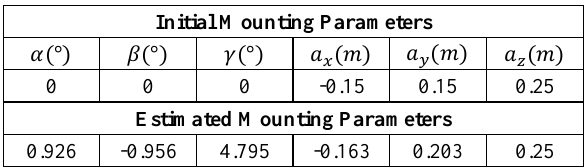
Table 3. Calibration result, mounting parameters